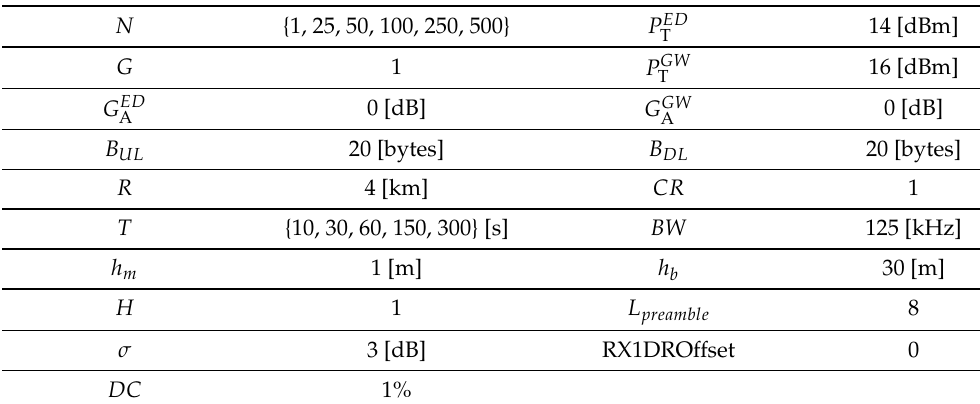
Table 9. Simulation parameters.